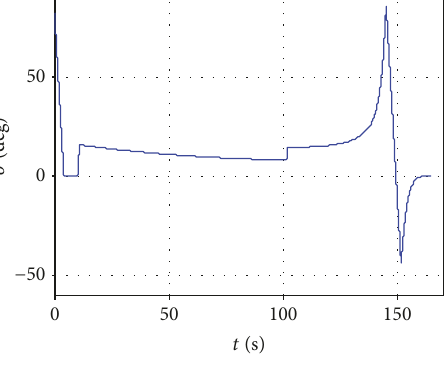
Figure 12: Bank angle with time. Table 3: Simulation results.